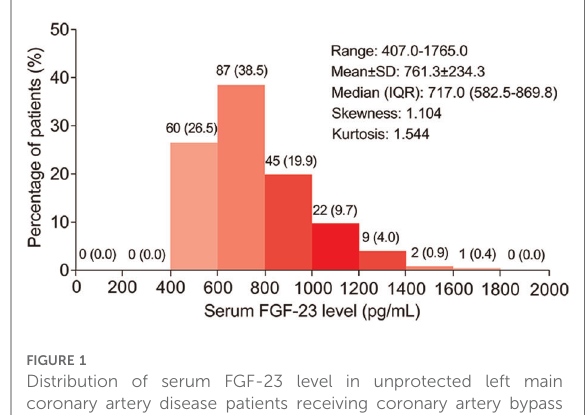
FIGURE 1 Distribution of serum FGF-23 level in unprotected left main coronary artery disease patients receiving coronary artery bypass grafting .